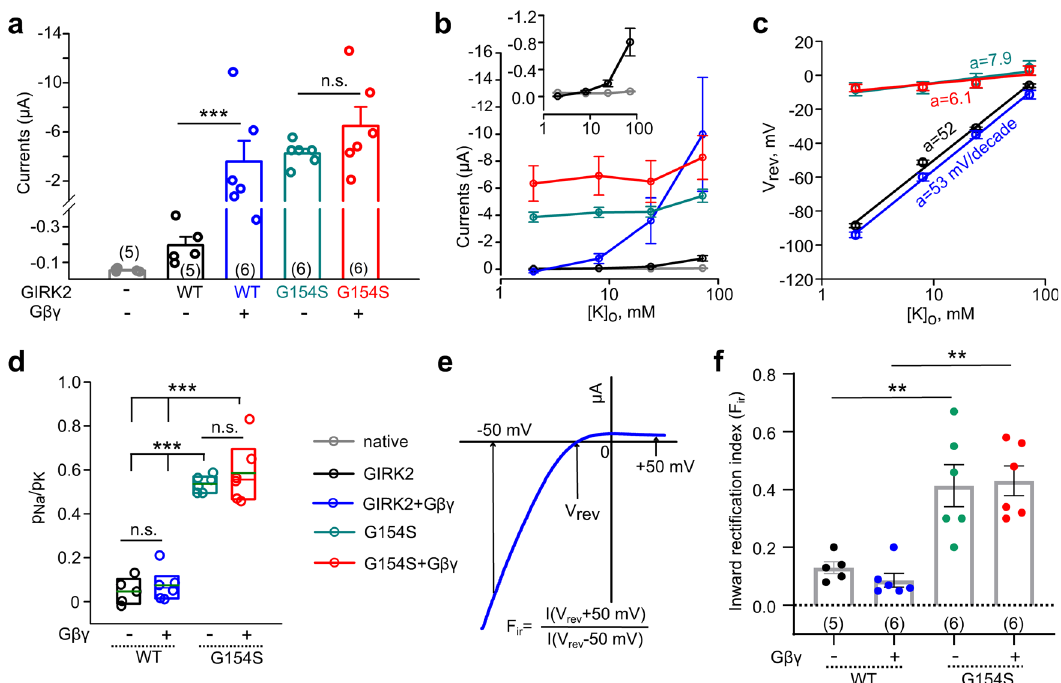
Fig. 4 hGIRK2 G154S channels are constitutively active and lose selectivity to K + . a Comparison of current amplitudes at − 80 mV in 24 K + . G βγ activates hGIRK2 wt (unpaired two-tailed t -test) but not hGIRK2 G154S . n = 5 – 7 oocytes (from one frog) in each group. The data in the bar graphs, here and in f , are presented as mean ± SEM. b Changes in current amplitudes as a function of external K + (note that K + isotonically replaced Na + , Cl − was kept constant). The inset zooms on native and hGIRK2 wt groups that showed lower currents. c The dependence of V rev on [K o ]. Note the log scale of the X -axis. The slopes ( a ; mV/decade) of the linear least square regression lines are indicated near each line. Data are shown as mean ± SEM from 6 to 7 oocytes in each group, from one frog. d p Na / p K permeability ratios, calculated from the reversal potentials obtained in 8 and 72 mM K + solutions, in the four test groups. Kruskal – Wallis one-way ANOVA on ranks, followed by Dunn ’ s pairwise multiple comparison test. In box plots, boxes show 25th and 75th percentiles. The horizontal lines colored as the box show the median, the green line shows the mean. *** p < 0.001. e An example of calculation of the recti fi cation index, F ir . f Comparison of F ir of hGIRK2 wt and hGIRK2 G154S channels with and without G βγ . ** p = 0.0065 and 0.0022. Numbers of oocytes tested are indicated below the